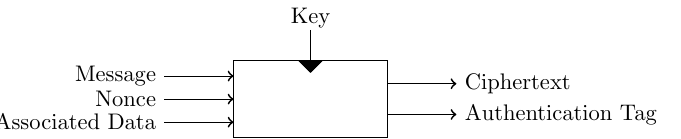
Figure 1: The high-level structure of the encryption algorithm of an AEAD scheme The round function of TinyJAMBU computes a permutation P b : F 128 b ∈ F 2 , which transforms a 128-bit state ( s 127 , s 126 , · · · , s 1 , s 0 ) to ( z, s 127 , s 126 , · · · , s 2 , s 1 ) with z = s 0 ⊕ s 47 ⊕ s 70 s 85 ⊕ s 91 ⊕ b . This permutation is depicted in Figure 2. Let l be the number of rounds. TinyJAMBU computes the l -round transformation with a given